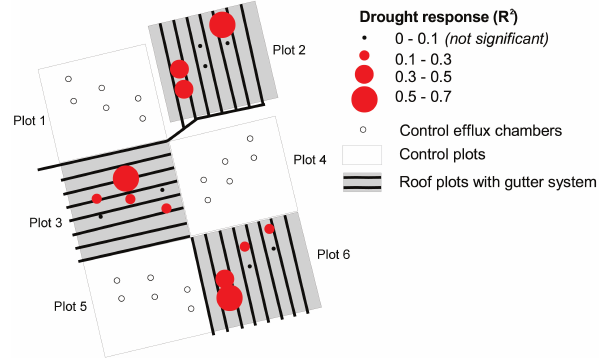
Fig. 2. Soil CO 2 efflux from drought responsive efflux chambers and non-responsive efflux chambers in the roof plots. Error bars in- dicate ± 1SE. The shaded area indicates the period of roof closure.